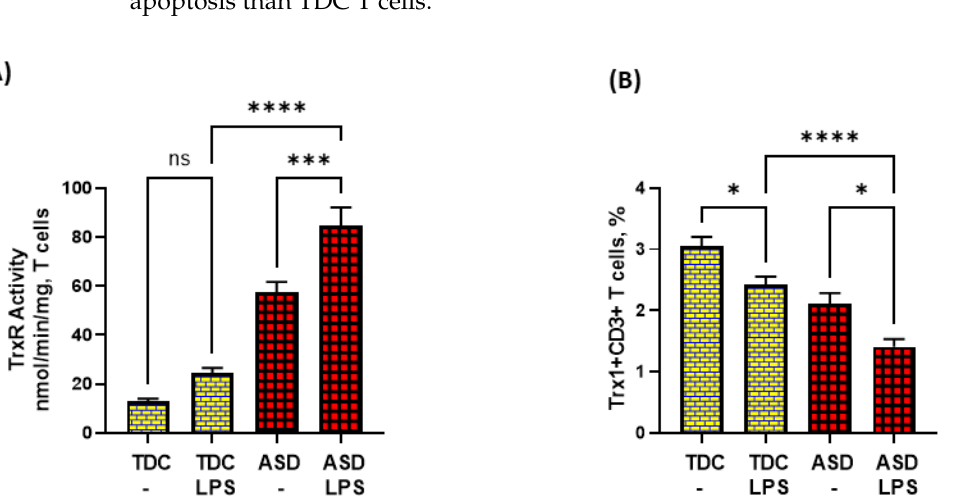
Figure 4. TrxR activity and Trx1 expression in the T cells of the ASD and TDC groups in response to LPS. ( A ) TrxR activity, and ( B ) % Trx1+CD3+ T cells. PBMCs and T cells were segregated from whole blood, followed by treatment with LPS, flow cytometry and enzymatic assays, respectively. Values are shown as the mean ± SEM, n = 15/group. * p < 0.05; *** p < 0.001; **** p < 0.0001.